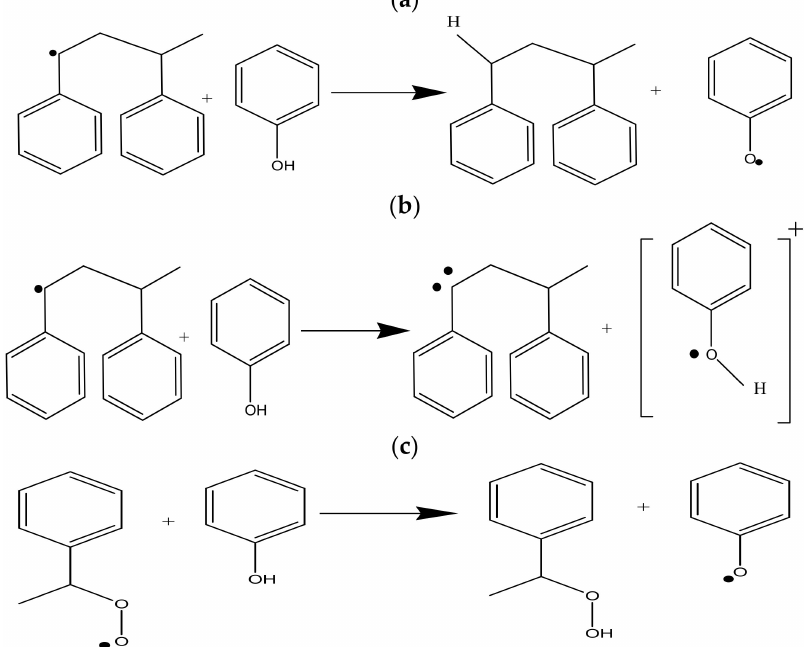
Figure 3. Mechanism of ( a ): H-atom donation, ( b ) electron donation, and ( c ) H-atom donation reaction in the presence of oxygen by typical phenolics. Hydrogen atoms are omitted for